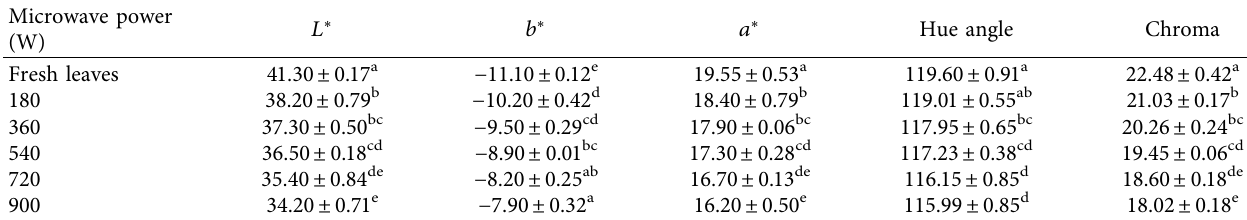
Table 3: Variation of color characteristics for the microwave drying of Stevia leaves.